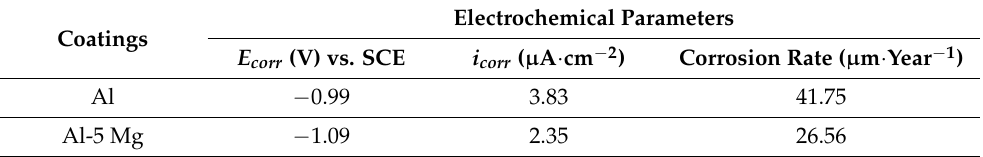
Table 3. Electrochemical parameters of the coating extracted after fitting in Tafel regions.